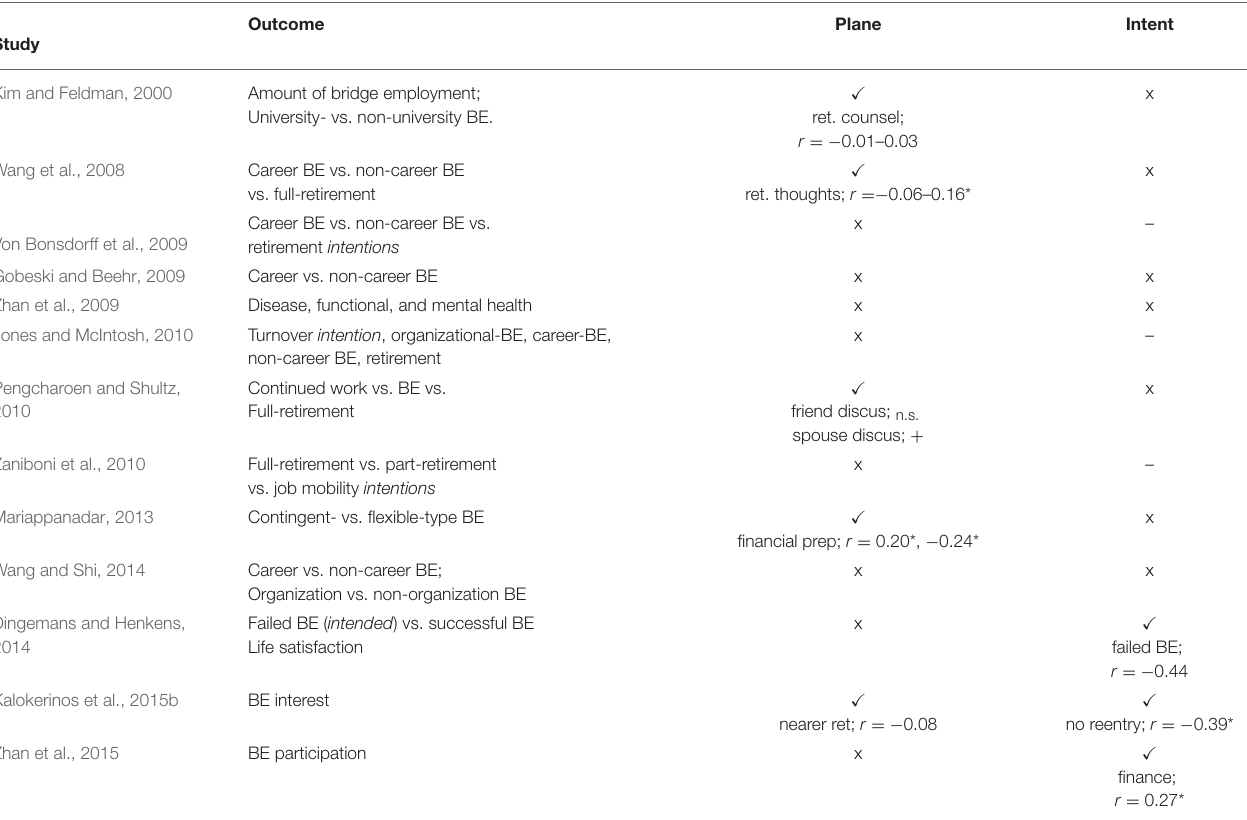
TABLE 1 | Summary bridge-employment studies scored by retirement “planning” or “intentions” inclusion.